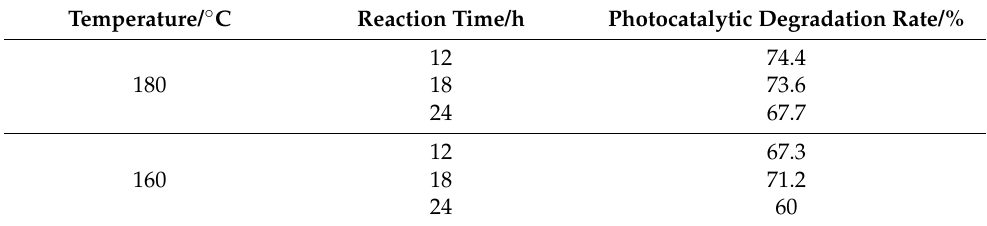
Table 1. Preparation conditions of